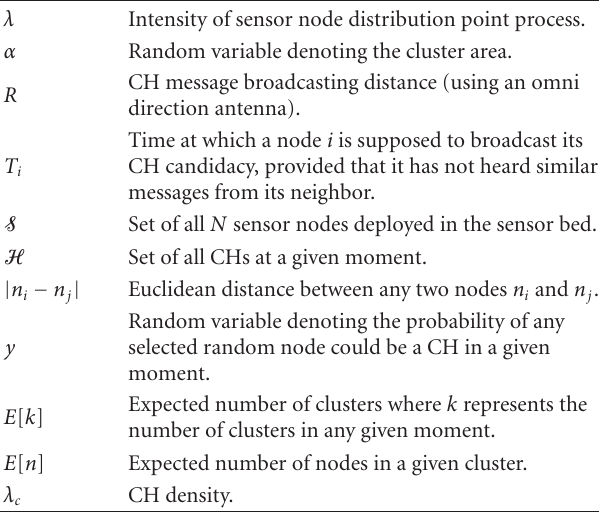
Table 1: Brief definition of some notations used in the